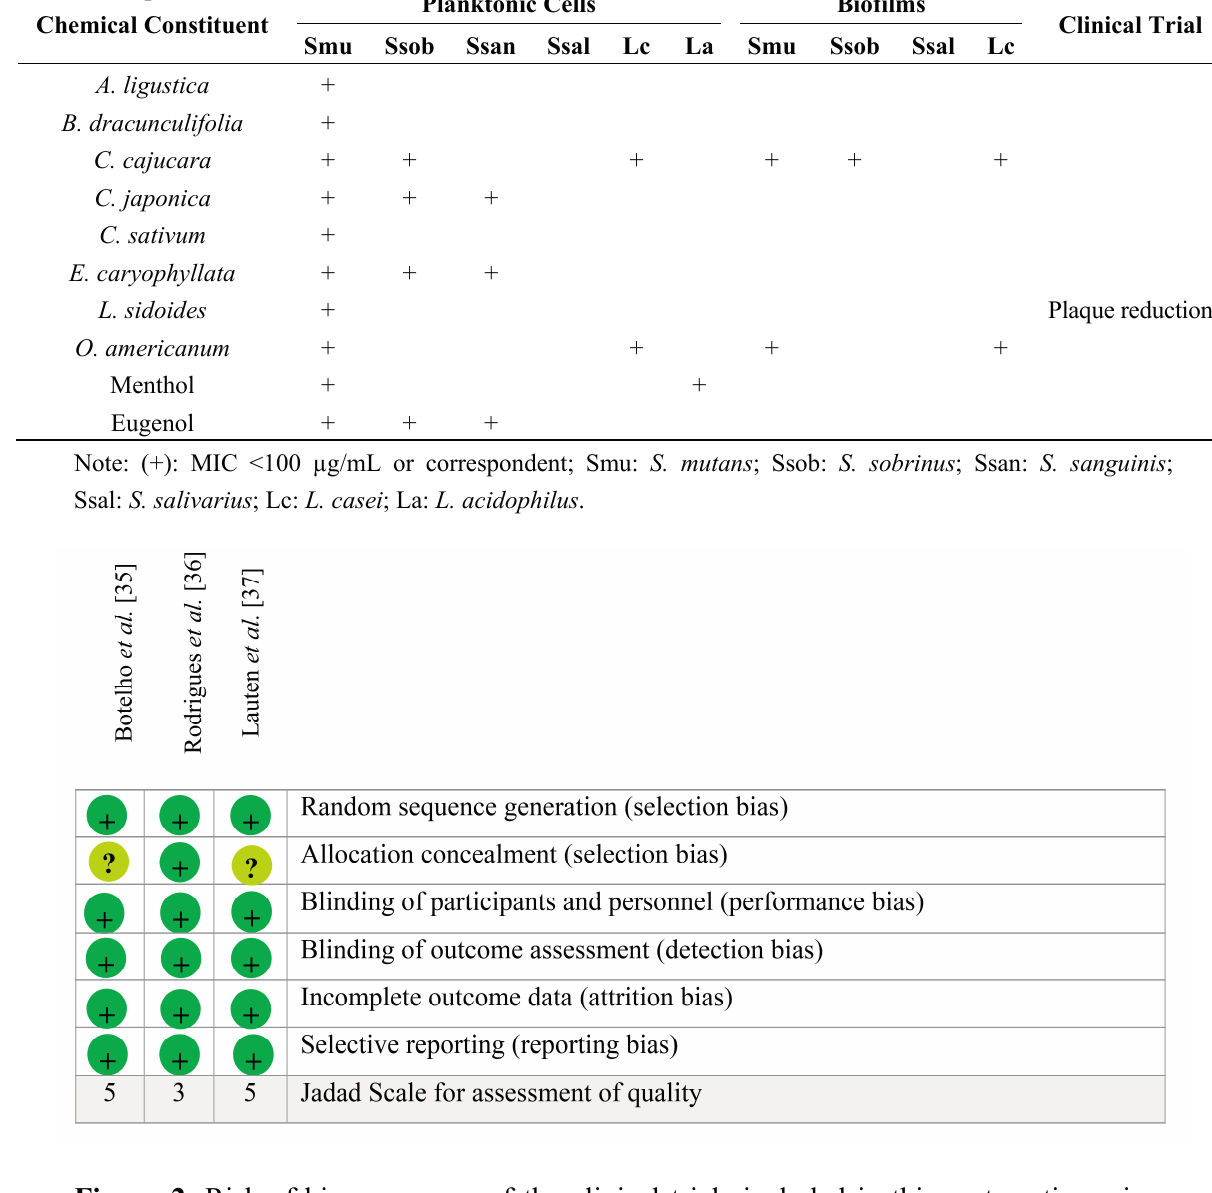
Figure 2. Risk-of-bias summary of the clinical trials included in this systematic review. Red ( − ) stands for high risk of bias, green (+) stands for low risk of bias and yellow (?) stands for unclear risk of bias. Overall, the studies are compliant with the CONSORT guidelines for clinical trials of herbal interventions, showing low risk of